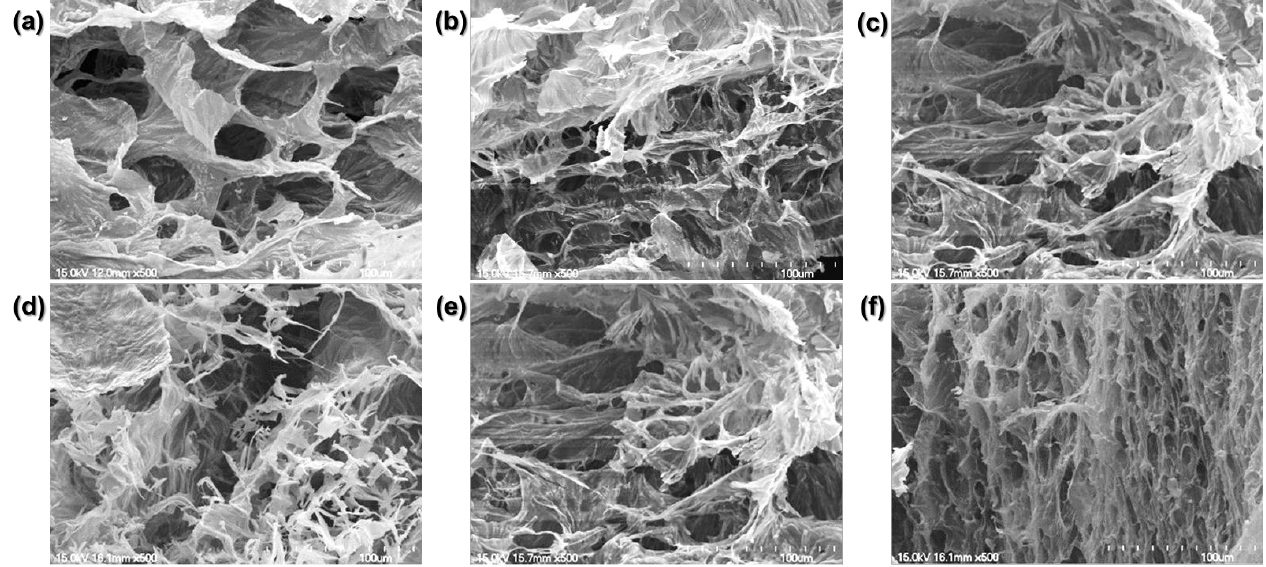
Figure 4. Scanning electron microscopy (SEM) images. ( a ) Physically crosslinked hydrogel. ( b ) 1 min, ( c ) 5 min, ( d ) 10 min, ( e ) 20 min, and ( f ) 30 min BL-activated RFP-induced chemically crosslinked collagen